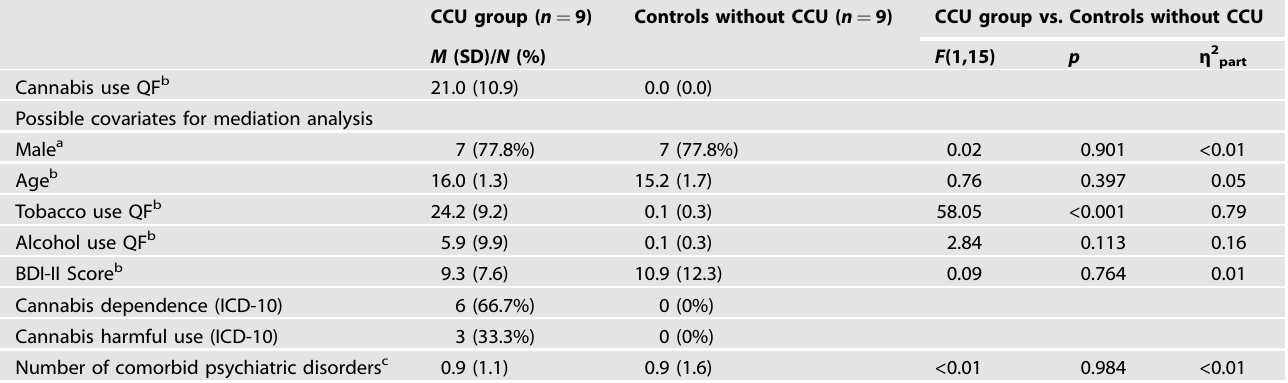
Table 2. Characteristics of demographics, substance use and comorbid disorders of the sample.